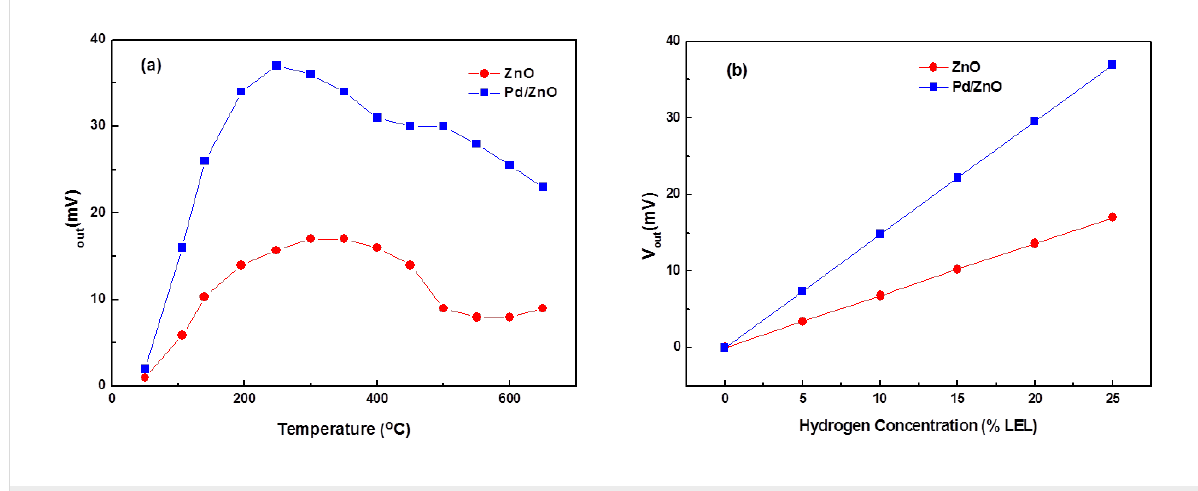
Figure 4: Dependence of (a) the operating temperature on the sensor sensitivity and (b) the hydrogen concentration on the sensor sensitivity (b).